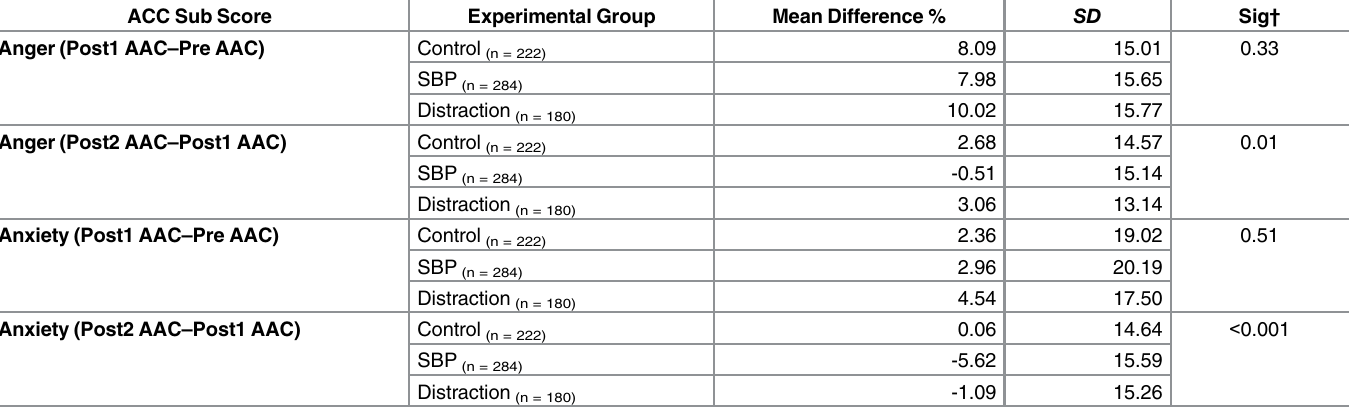
Table 1. Percentage differences between Post1-Pre and Post2-Post1 of the Anger and Anxiety AAC Composite Scores means of the University Group. ACC Sub Score